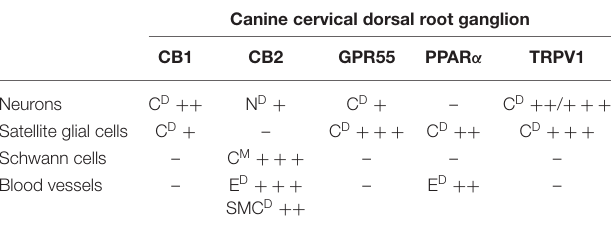
TABLE 4 | Semiquantitative evaluation of the density of CB 1 , CB 2 , GPR55, PPAR α , and TRPV1 receptors immunoreactivity in different cellular